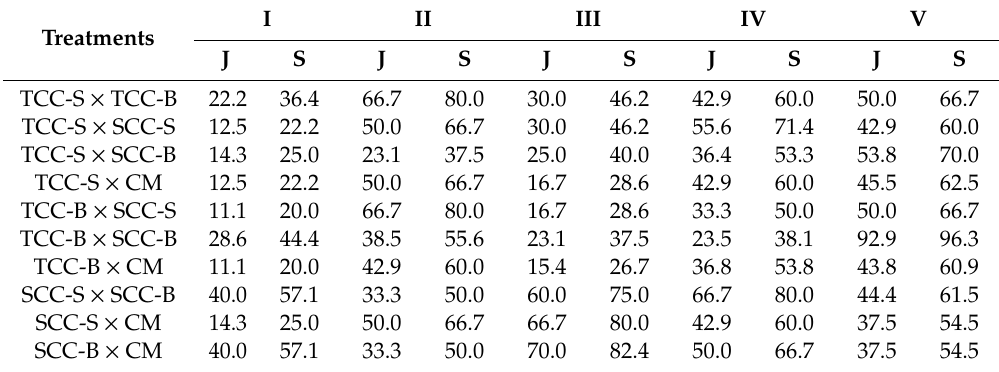
Table 3. Jaccard’s (J, %) and Sørensen’s (S, %) similarity coe ffi cients of β -diversity for a 5-cover cropping × 5 seasons system in an apricot orchard.